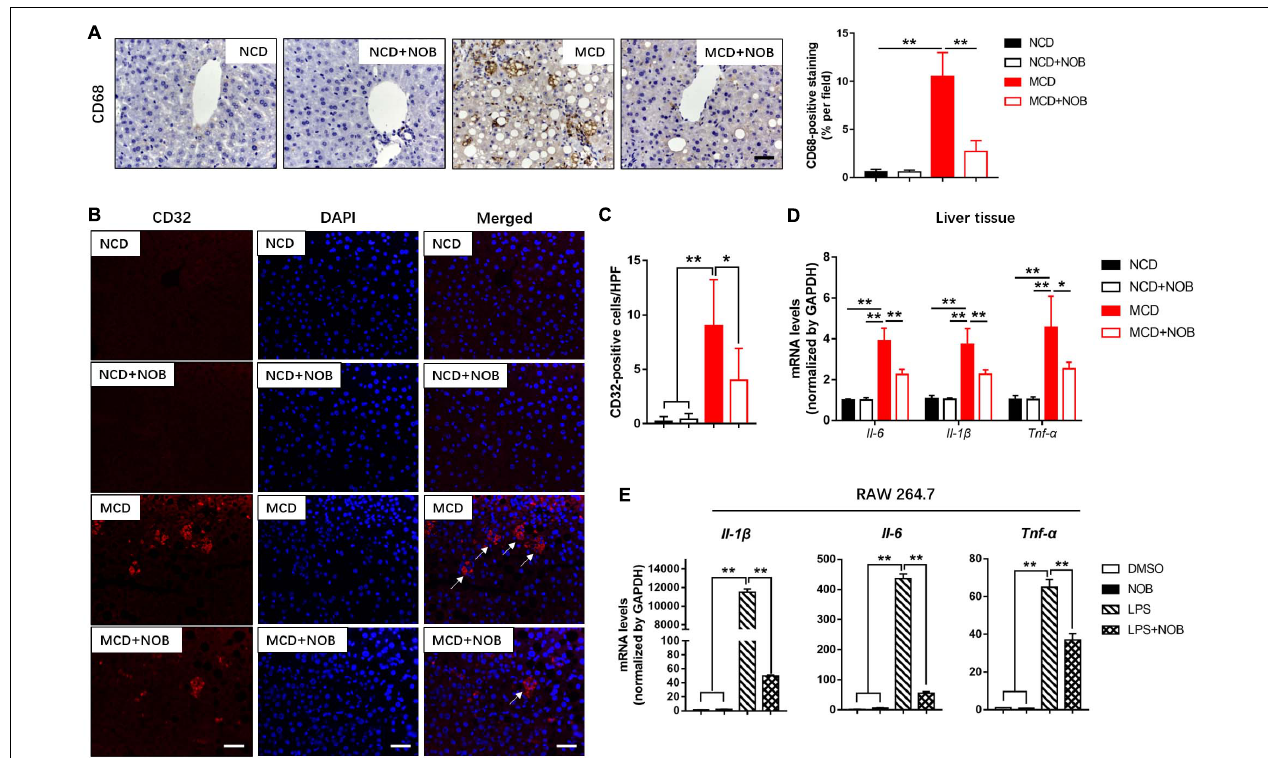
FIGURE 4 | The effect of NOB on M1 macrophage polarization and expression of inflammatory properties in liver tissue and RAW 264.7 cells. (A) Left, the representative images of CD68 immunohistochemical staining in liver from each group. Scale bar = 300 µ m. Right, quantification and statistical analysis of CD68-stained areas. Data were expressed as the mean ± SD ( n = 8). (B) Representative fluorescence microscopic images of CD16/32-stained liver sections. Scale bar = 300 µ m. (C) Quantification and statistical analysis of CD16/32-positive cells in liver tissue. We measured the number of CD16/32-positive membranes from at least five high power fields (HPF, original magnification, 400 × ). (D) The mRNA levels of Il-6 , Il-1 β and Tnf- α in livers of MCD-induced mice were evaluated using RT-qPCR. Data were expressed as the mean ± SD ( n = 5). (E) RAW 264.7 cells were pretreated with DMSO, NOB (100 µ M), LPS (200 ng/mL), or LPS (200 ng/mL) + NOB (100 µ M) for 16 h. The expression of proinflammatory factors Il-6 , Il-1 β , and Tnf- α determined by RT-qPCR. Values are expressed as mean ± SD ( n = 3). * P < 0.05, ** P <